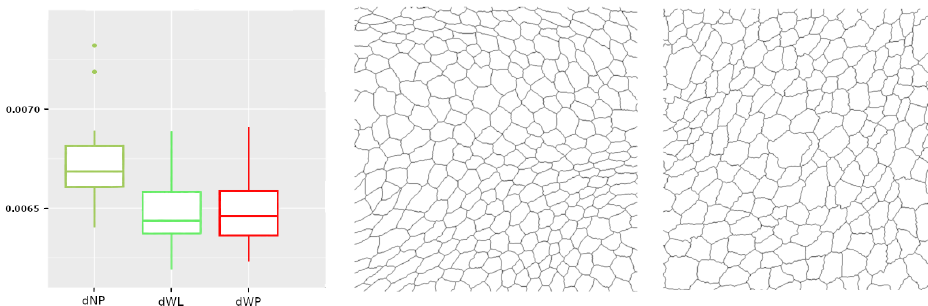
( 0.10 N ) . On the right are the images of dNP 0